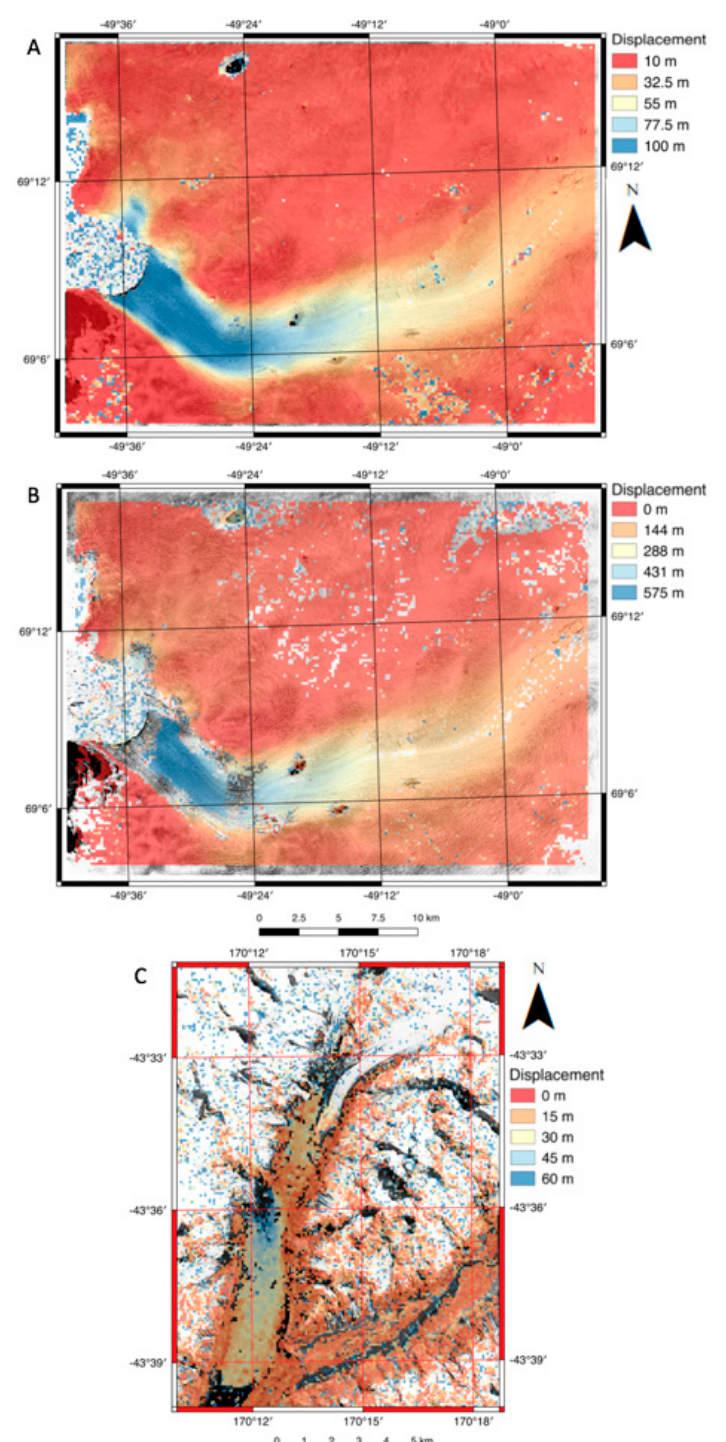
Figure 6. ( A ) Displacement map of pair J1: 29.07.2017–03.08.2017 over Jakobshavn Isbræ displaying smooth displacement signal over entire glacier with maxima of over 155 m at the terminus; ( B ) Displacement map of pair J2: 21.07.2017–15.08.2017 over Jakobshavn Isbræ displaying decorrelated displacement signal at the terminus and at the sharp change in flow direction; ( C ) Displacement map of pair 29.09.2017–11.02.2018 over the Tasman Glacier showing smooth displacement signal across the debris covered part of the glacier.